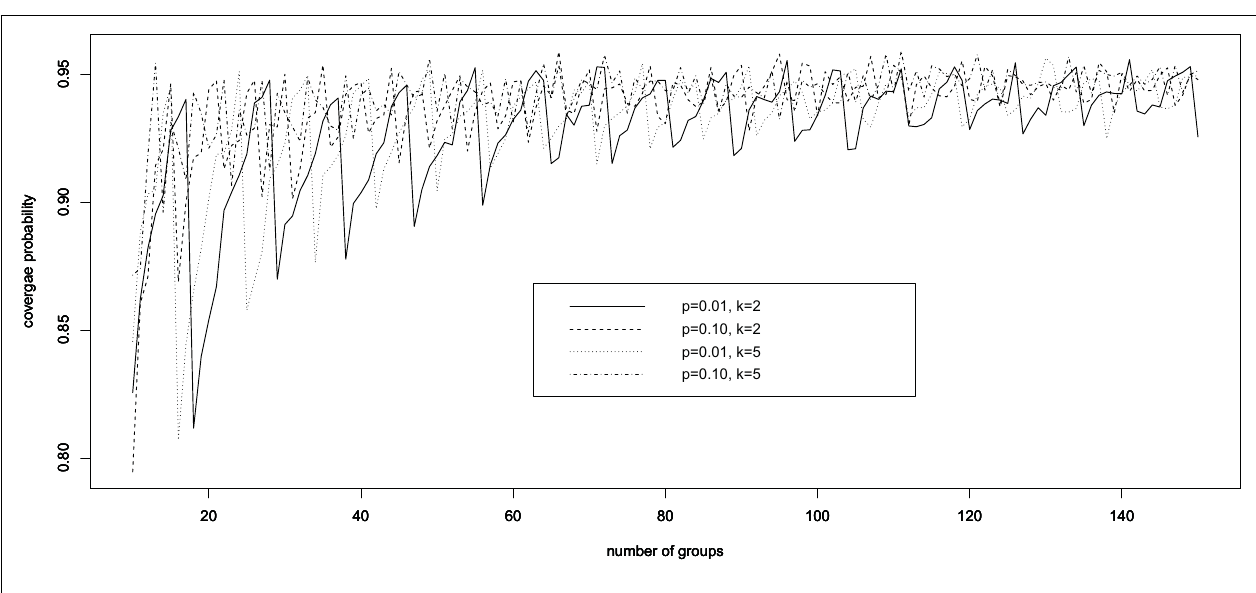
FIGURE 1 |The oscillation up-and-down behavior of theWald confidence interval under pooled testing with misclassification.